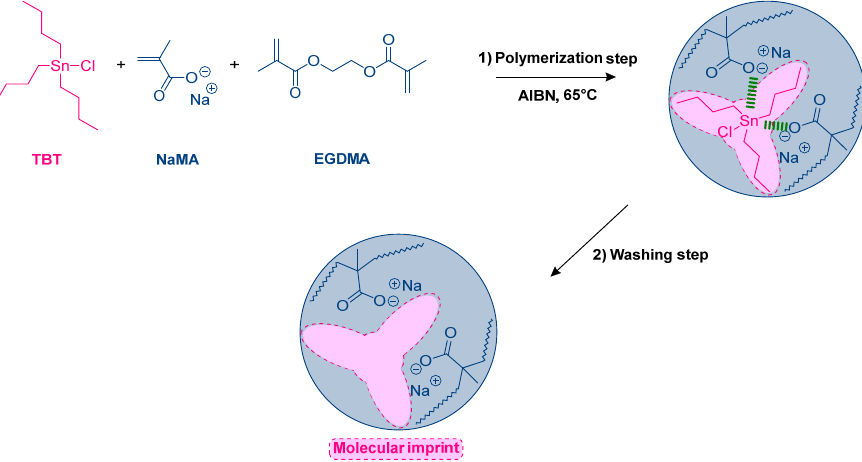
Figure 1. Schematic representation of the MIP synthesis.